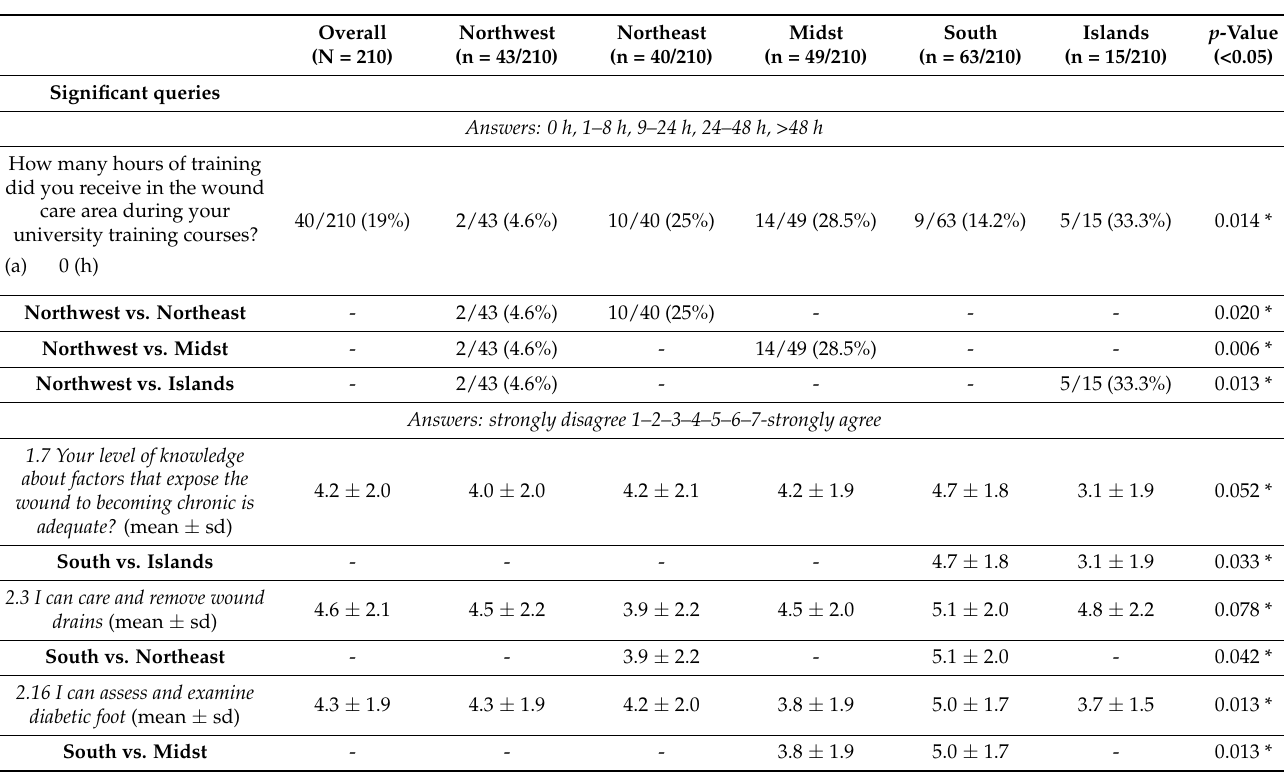
Table 2. Summary of significant